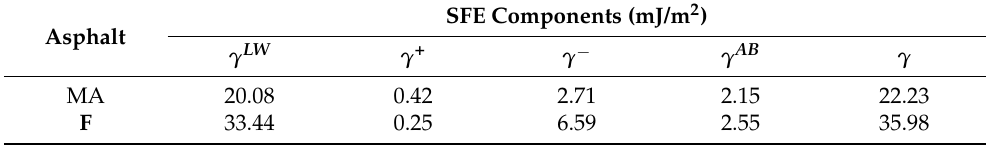
Table 5. SFE parameters of MA and F